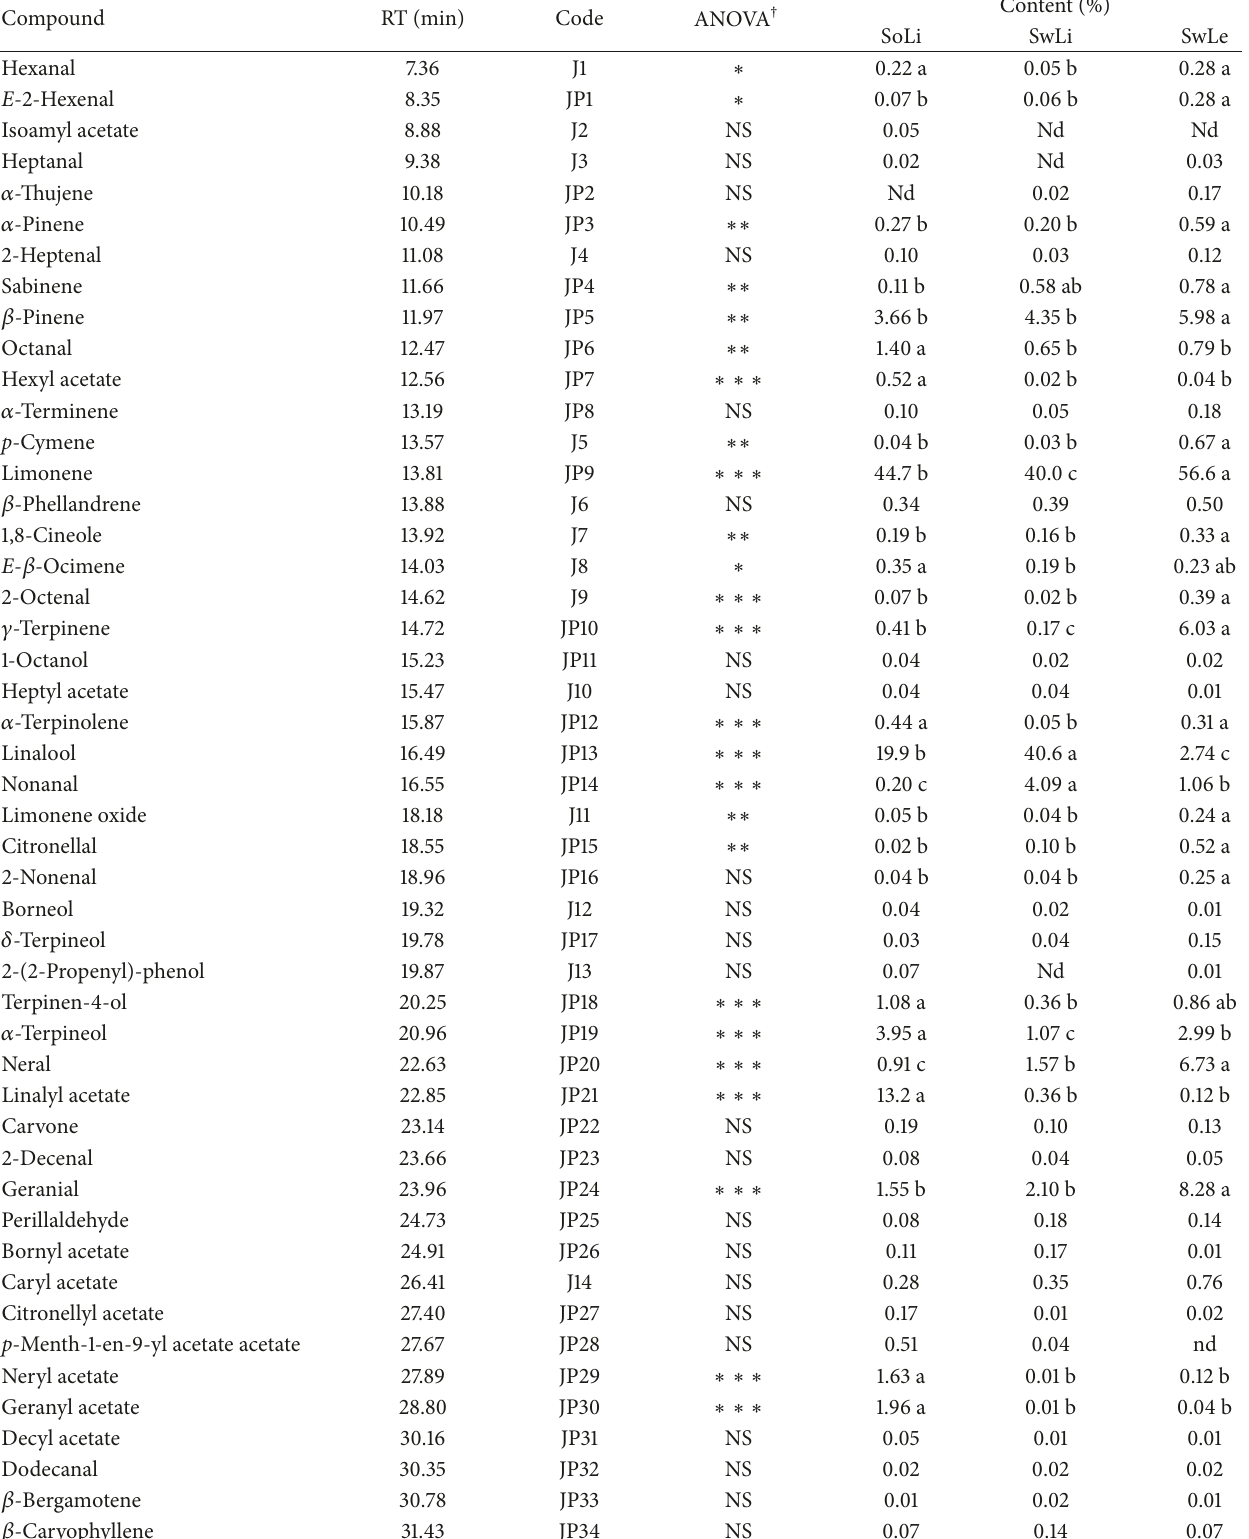
Table 4: Volatile compounds (%) in the juice of endangered Spanish sour (SoLi) and sweet (SwLi) limes and sweet lemon (SwLe).